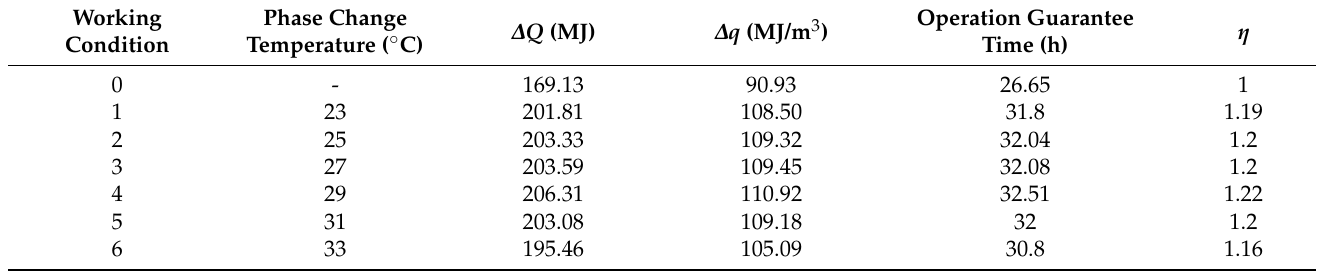
Table 4. Effect of phase change temperature on the performance of the